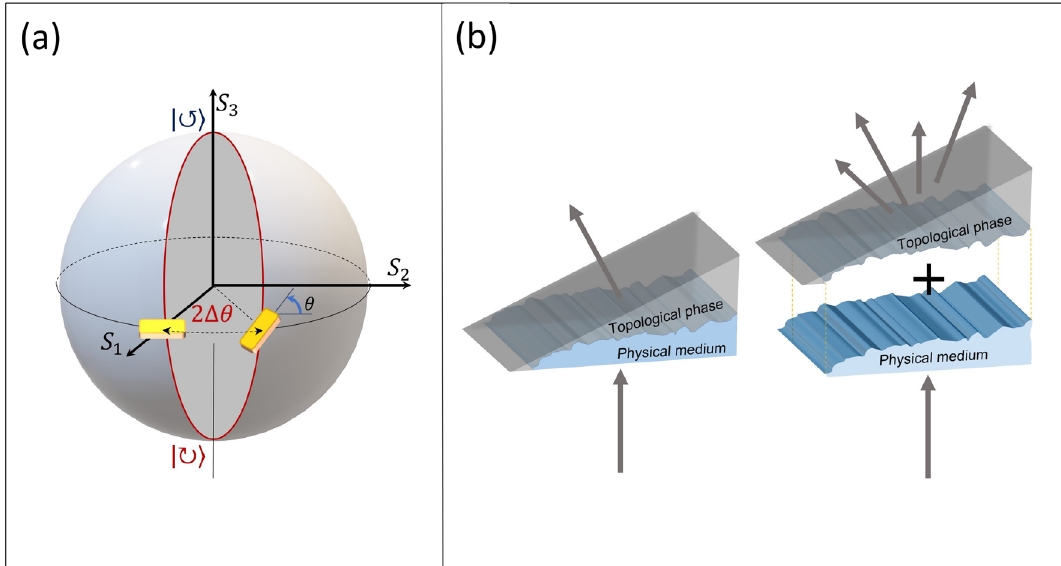
Figure 1. ( a ) Visualization of the TP on the Poincaré sphere due to rotating apertures. The angle of the anisotropy axis, θ , corresponds to the longitudinal line of the sphere with the same angle. Subsequently, the solid angle subtended (in red) is then the topological phase accrued by coherent light passing through both apertures. ( b ) Graphic presentation of the combined effect of the plasmonic grating and the topological phase. The randomized physical medium and the topological phase apart scatter incident light in all angles, but once coupled the light is diffracted in a topologically protected